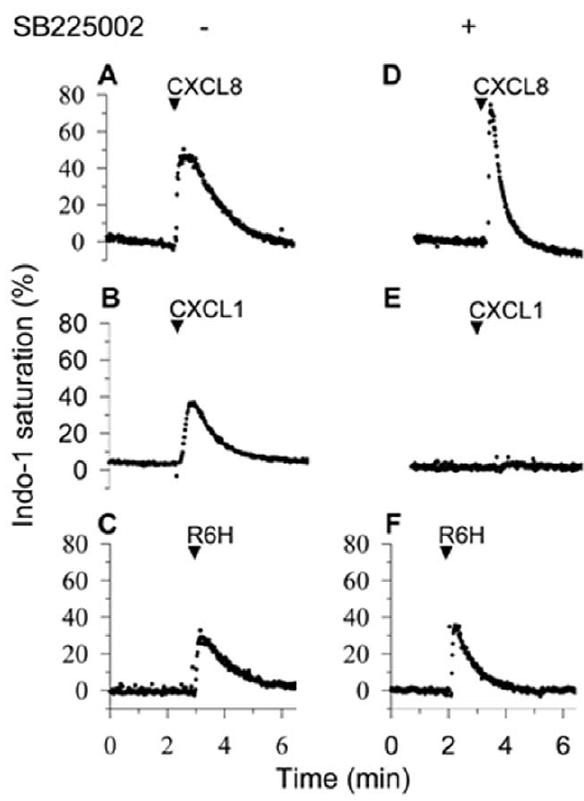
Figure 5. The R6H-CXCL8 and CC-CXCL8 mutants differentially desensitized the calcium responses mediated by CXCR2. Human neutrophils loaded with Indo-1 were first stimulated with 100 nM of R6H-CXCL8 and then challenged with 100 nM R6H-CXCL8 (A) or the 100 nM CXCR2 agonist CXCL1 (C). Similarly, neutrophils were first stimulated with 100 nM of CC-CXCL8 and then challenged with 100 nM CC-CXCL8 (B) or 100 nM CXCL1 (D). Conversely, neutrophils were first treated with 100 nM CXCL1 and then challenged with 100 nM of R6H- CXCL8 (E) or CC-CXCL8 (F).